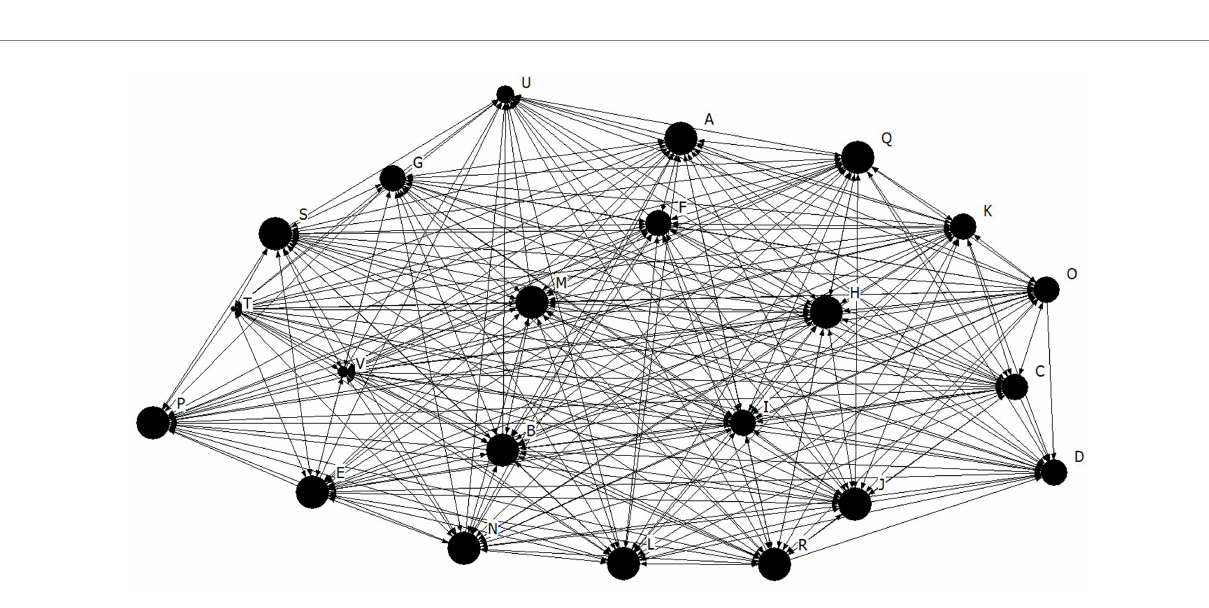
FIGURE 2 Network diagram for task cohesion. Dots indicate each team member, Size of dot indicates relative indegree centrality for task